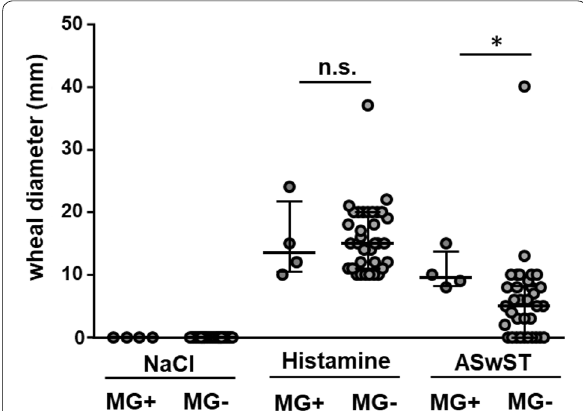
Fig. 2 Skin reactivity in the ASwST with histamine as positive and NaCl as negative controls. Differences between the CholU patients with elevated specific IgE levels against supMGL-1304 (MG and CholU patients with normal low supMGL-1304 (MG are shown. Median and interquartile ranges of the largest wheal size measured are